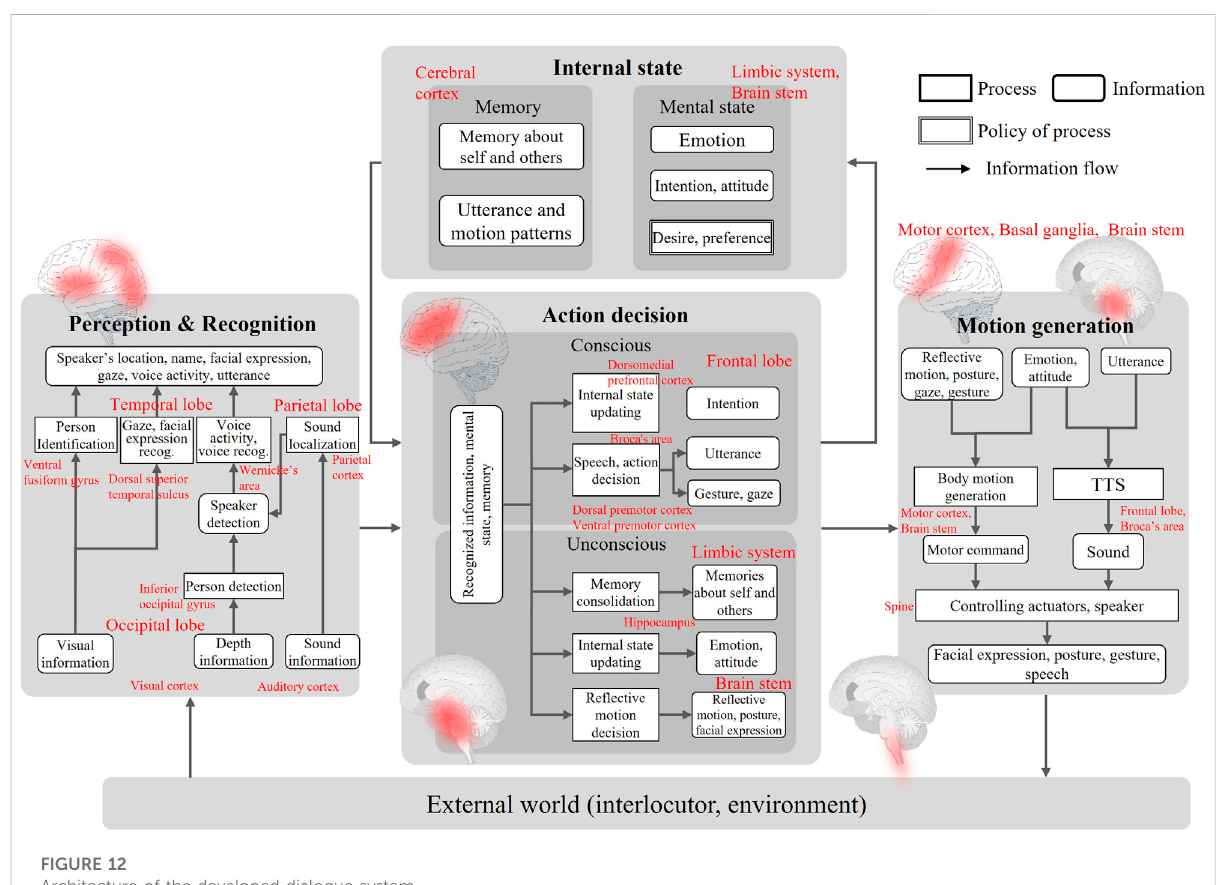
FIGURE 12 Architecture of the developed dialogue